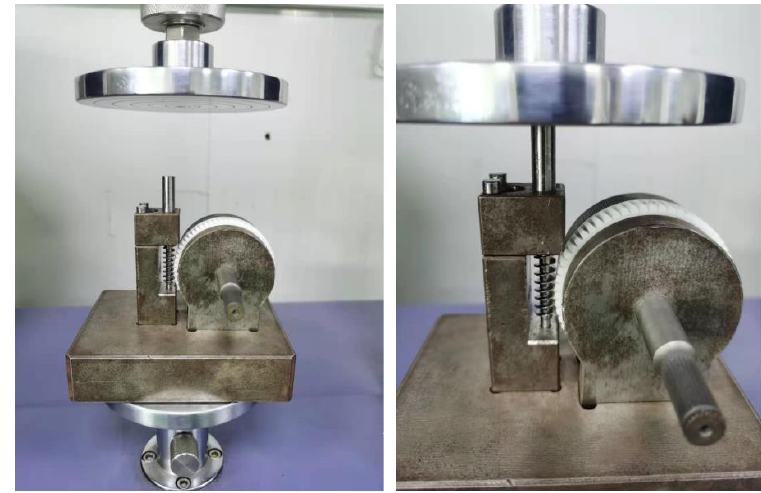
Figure 16. Test process.